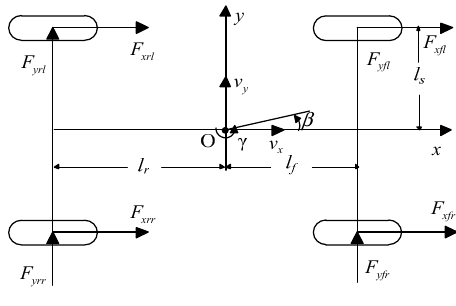
Figure 1. Skid Steering Vehicle Model.